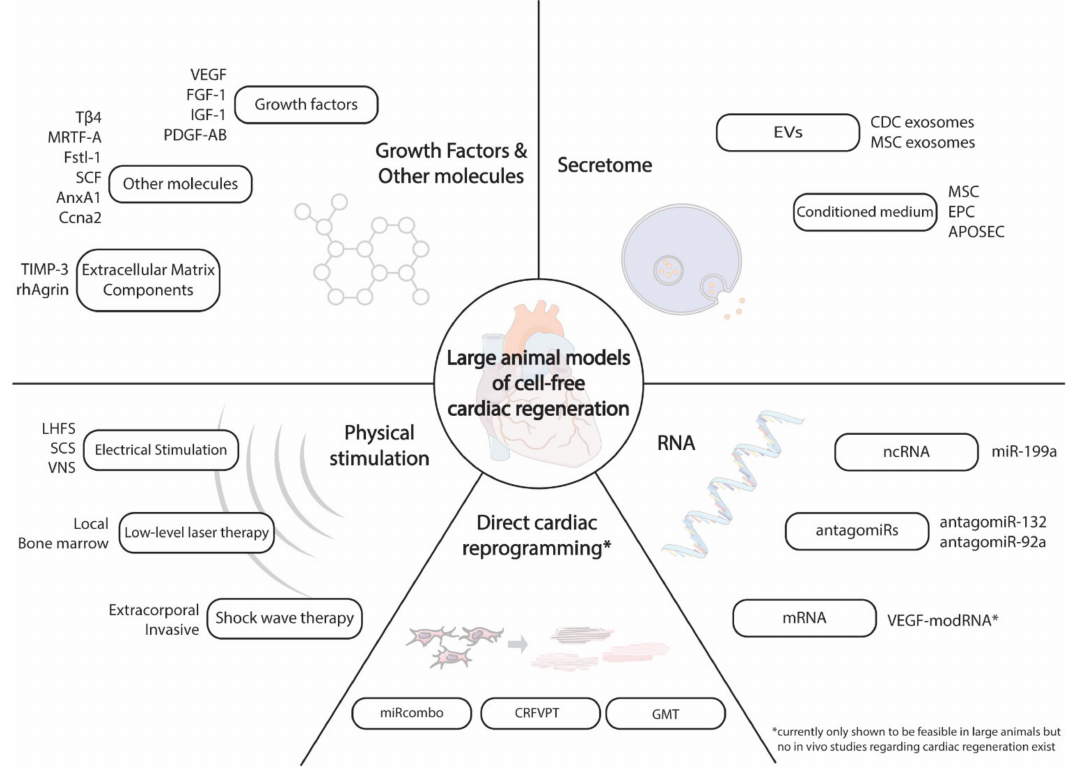
Figure 1. Overview of large animal models of cell-free cardiac